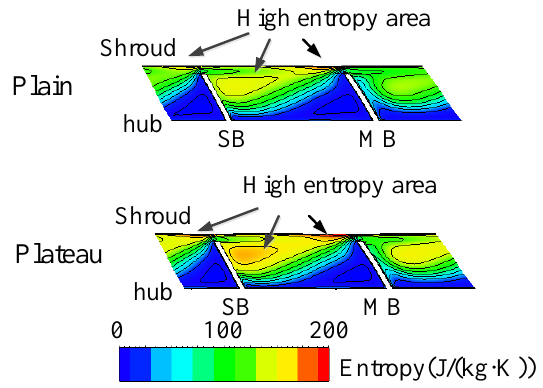
Figure 19. Entropy distribution at channel section of the impeller trailing edge.